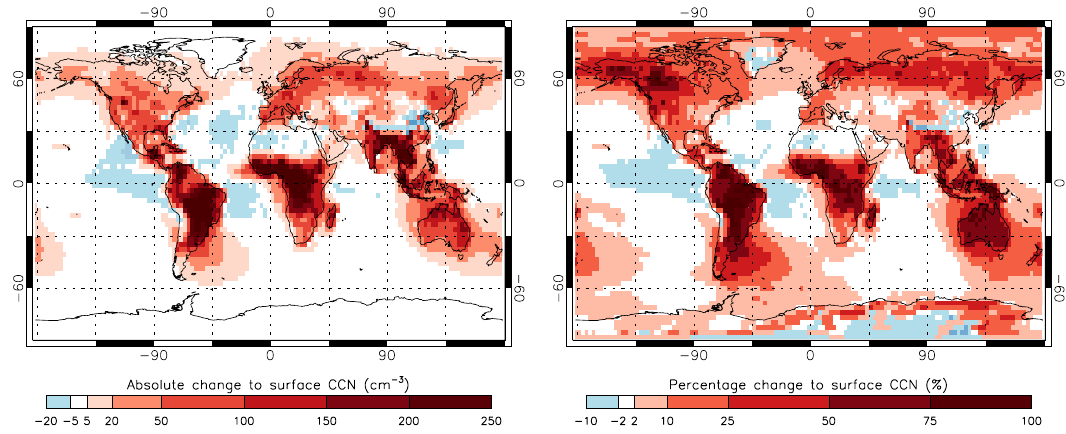
Fig. 1. Simulated annual mean absolute (left) and percentage (right) change to surface cloud condensation nuclei (CCN) number concen- tration, calculated at 0.2% supersaturation, resulting from the emission of both monoterpenes and isoprene when the ACT mechanism is